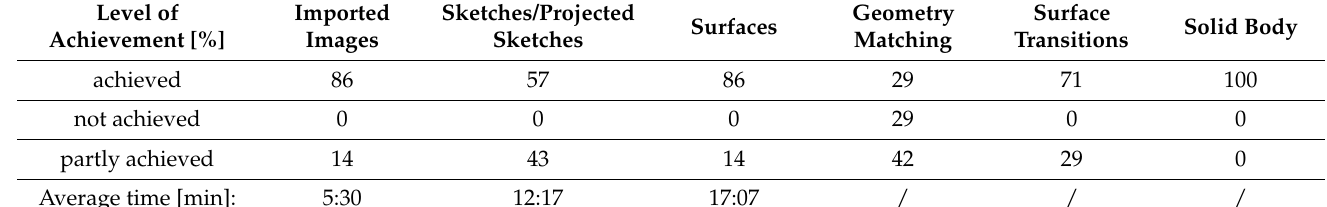
Table 4. VR modelling participant study—level of task achievement.